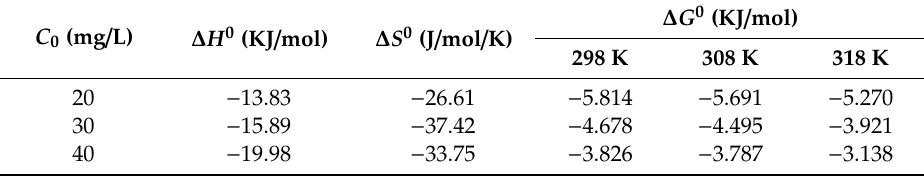
Figure 14. Thermodynamic fitting of the adsorption of Hg(II) by CoFe 2 O 4 @SiO 2 -EDTA.